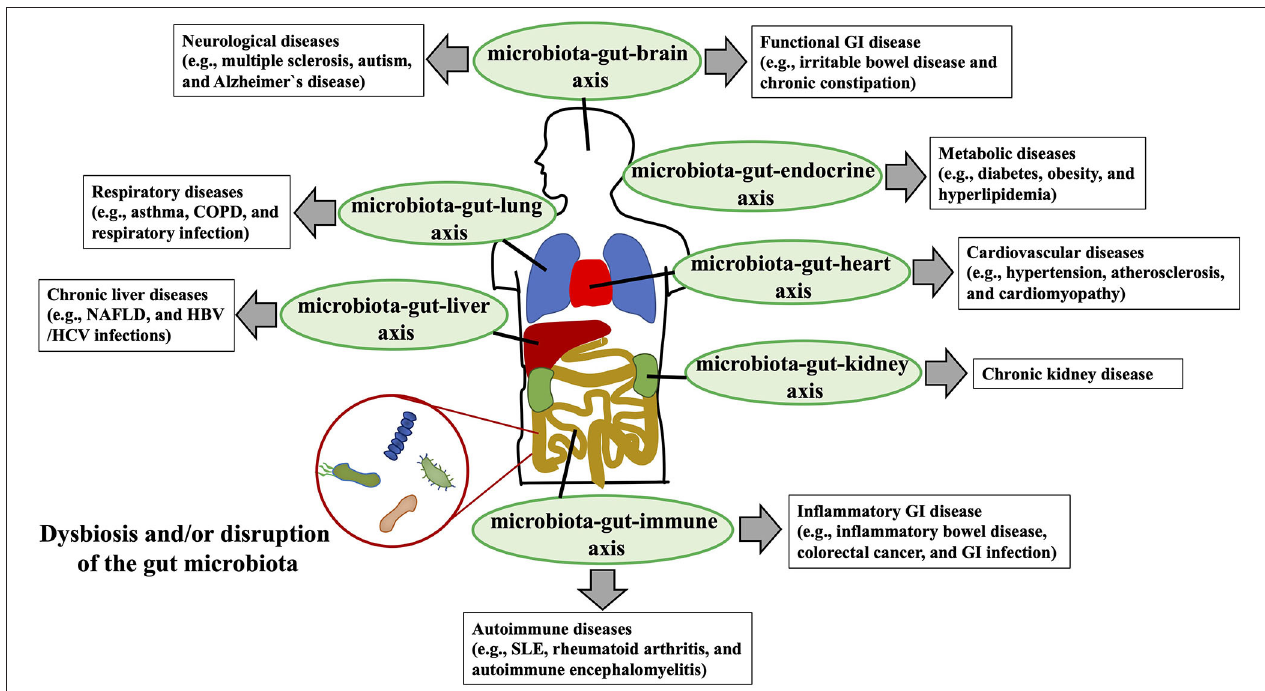
FIGURE 1 | Interaction between dysbiosis or disruption of the gut microbial community and human diseases. Dysbiosis or disruption of the gut microbiota composition that is induced primarily through an imbalanced lifestyle (e.g., high-fat, low-fiber diet) leads to the disruption of the gut barrier, increased gut permeability, systemic circulation of bacterial endotoxins [e.g., lipopolysaccharide (LPS)] to multiple organs (e.g., liver, brain, kidney) and functional systems (e.g., immune system, endocrine systems), and altered production of beneficial metabolites [e.g., short-chain fatty acids (SCFAs)] by normal gut microbiota. Bidirectional and unfavorable crosstalk among the dysbiotic microbiota, gastrointestinal system, and target organs and functional systems (e.g., microbiota-gut-liver axis, microbiota-gut-brain axis) is involved in the pathogenesis of the various diseases (e.g., NAFLD, chronic kidney diseases, Alzheimer’s disease, asthma) of the host. COPD, chronic obstructive pulmonary disease; NAFLD, non-alcoholic fatty liver disease; GI, gastrointestinal; SLE, systemic lupus erythematosus; HBV, hepatitis B virus; HCV, hepatitis C